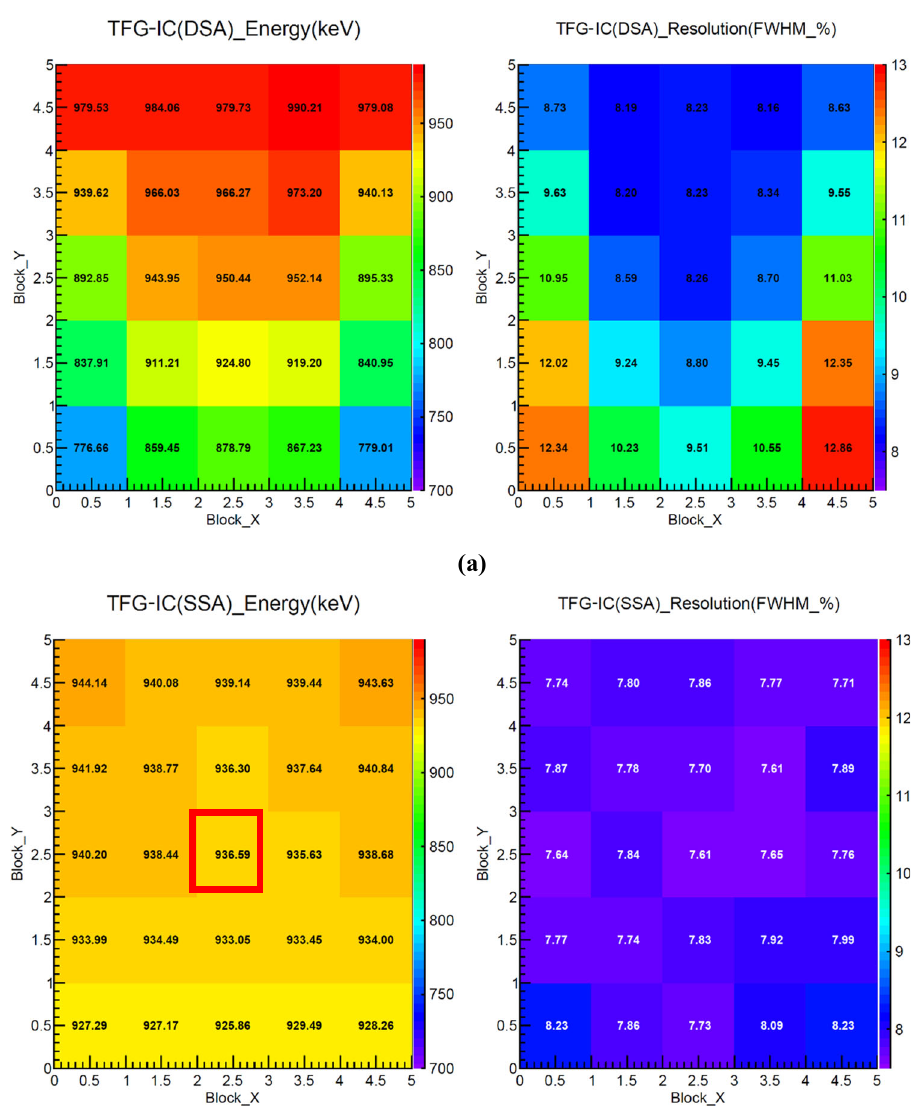
Fig. 8 Energy spectra of alpha particles measured in different areas of the longitudinal section of two different structures of ionization chambers at 200 mbar pressure with DSA structure sealed windows ( a ) and with SSA structure sealed window ( b ). The red frame ( b ) refers to block 13 in Fig.